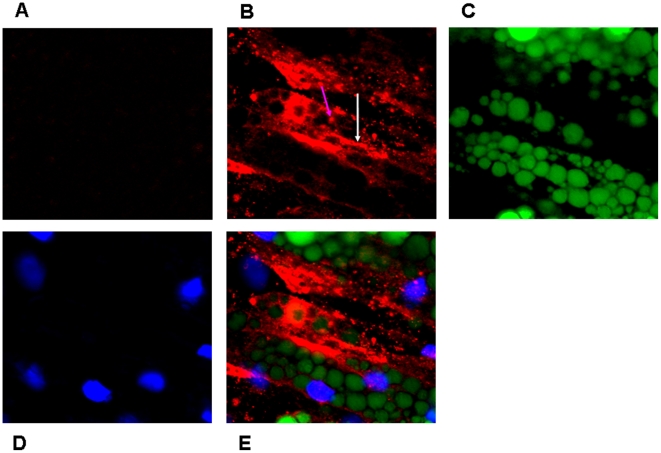
The localization and visualization of C-RP in the human adipocytes using confocal microscopy strategy.Confocal microscopy analysis was used to localize C-reactive protein (CRP) in the human adipocytes. An adipocyte wet slide was stained only with IgG isotype and alexa 647 coupled goat anti-mouse (panel A); considered as a negative control). This slide was not incubated with primary monoclonal antibody (Mab) against human CRP. Another adipocyte wet slide was also stained with Mab against human CRP and bound antibodies were displayed with alexa 647 coupled goat anti-mouse (panel A and E; red color). Fat organelle (lipid droplets) was visualized with FITC (C; green color), and adipocytes were stained with DAPI to detect nuclei (panel D; blue color). Panel E shows a merging of all three labels. Fluorescent labeling was used for all detections. CRP was found to be positive in cytoplasm and plasma membrane of human adipocytes and this confirmed the gene expression of CRP in both pre-adipocytes and adipocytes obtained by Illumina BeadArray (
Table 1
). White and red arrows indicate the presence of CRP on cytoplasm and plasma membrane, respectively (panel B).